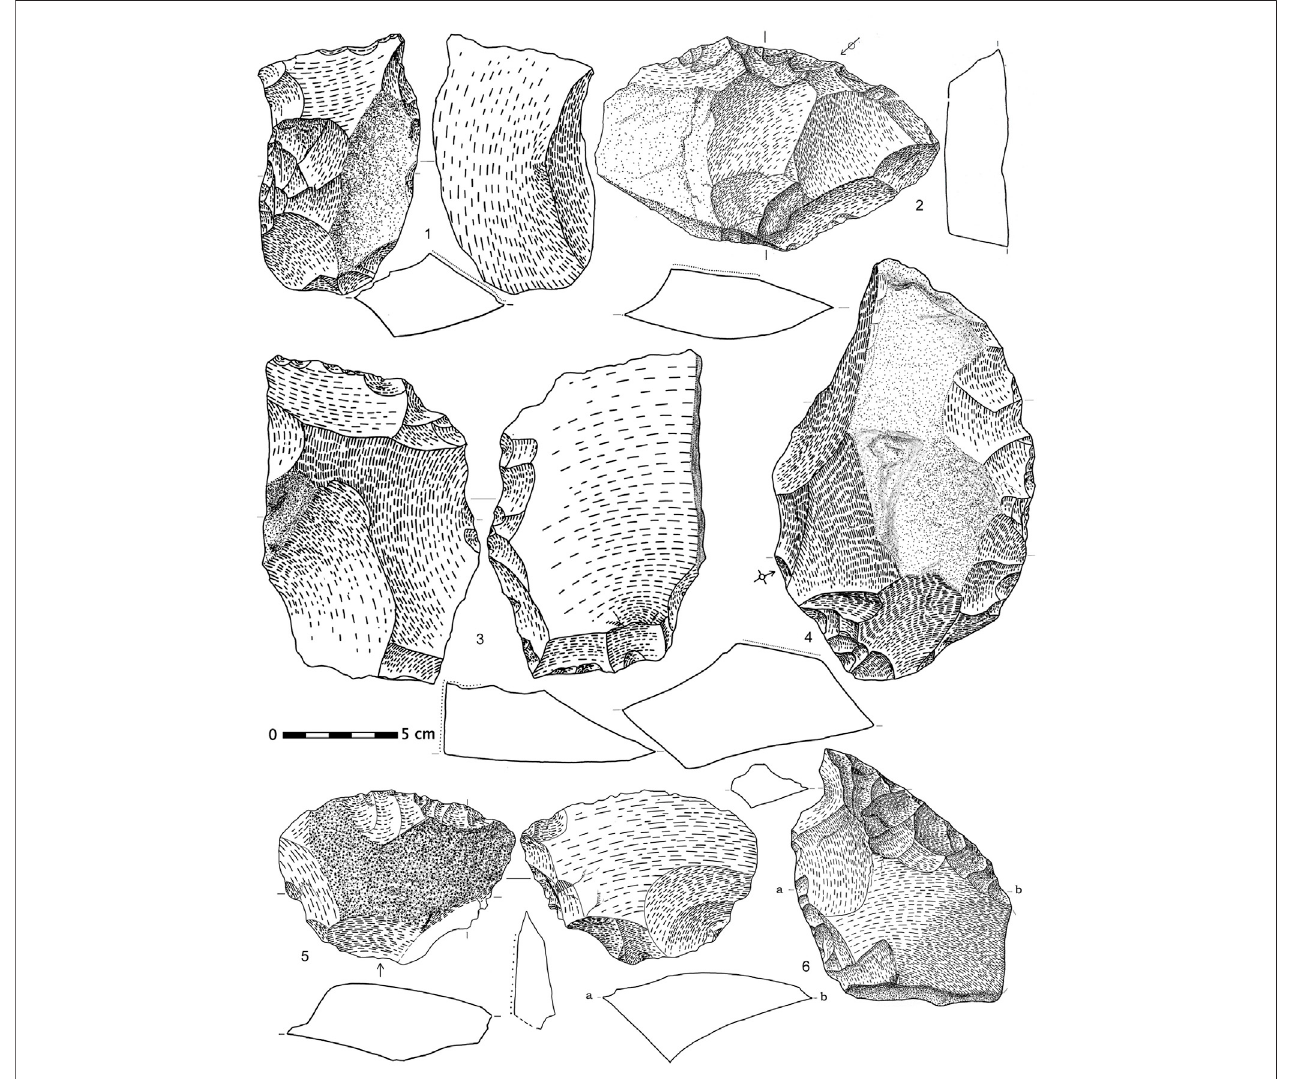
FIGURE 7 | Scrapers on large fl akes: Single transversal (1, 2 and 4), inverse (3) and convergents (5 and 6, this one associated whit a notche). All on quartzite.